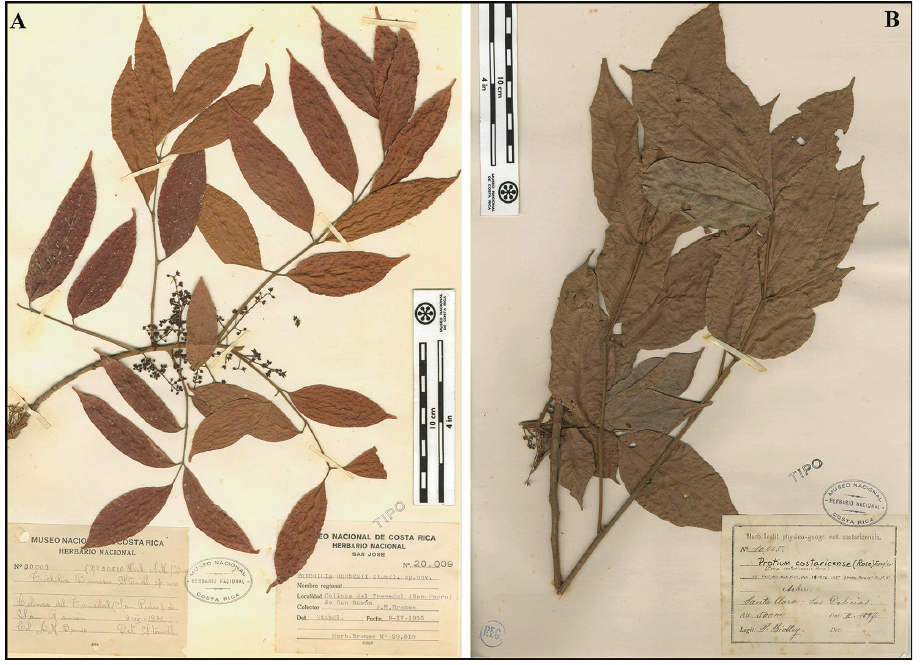
Figure 8. Types of Protium brenesii ( A ) and P. costaricense ( B ). Images courtesy of Museo Nacional de Costa